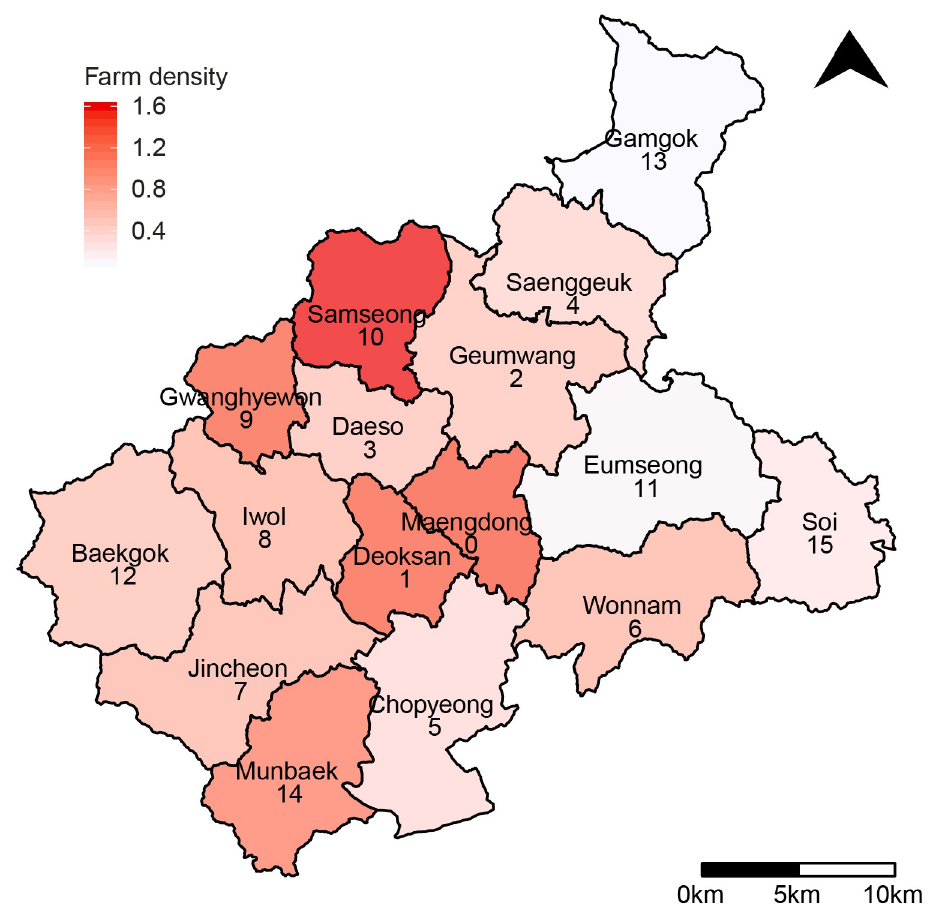
Fig 1. Map of Eumseong-gun and Jincheon-gun, which are the municipal-level divisions located in the central part of the Republic of Korea, including the density of poultry farms with white indicating low density and red indicating high density. The index of the town is written below its name. There are 16 towns; 9 towns in Eumseong- gun and 7 in Jincheon-gun. Reprinted from [27] under a CC BY license, with permission from National Geographic Information Institute, original copyright